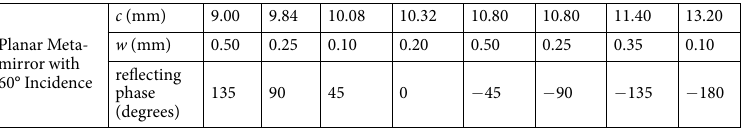
Table 1. The dimensions and the corresponding reflecting phases of the ring patches for the planar meta- mirror with 60° incidence and − 10°